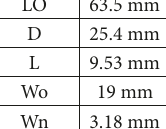
Figure 1: Geometrical parameters of the specimen.